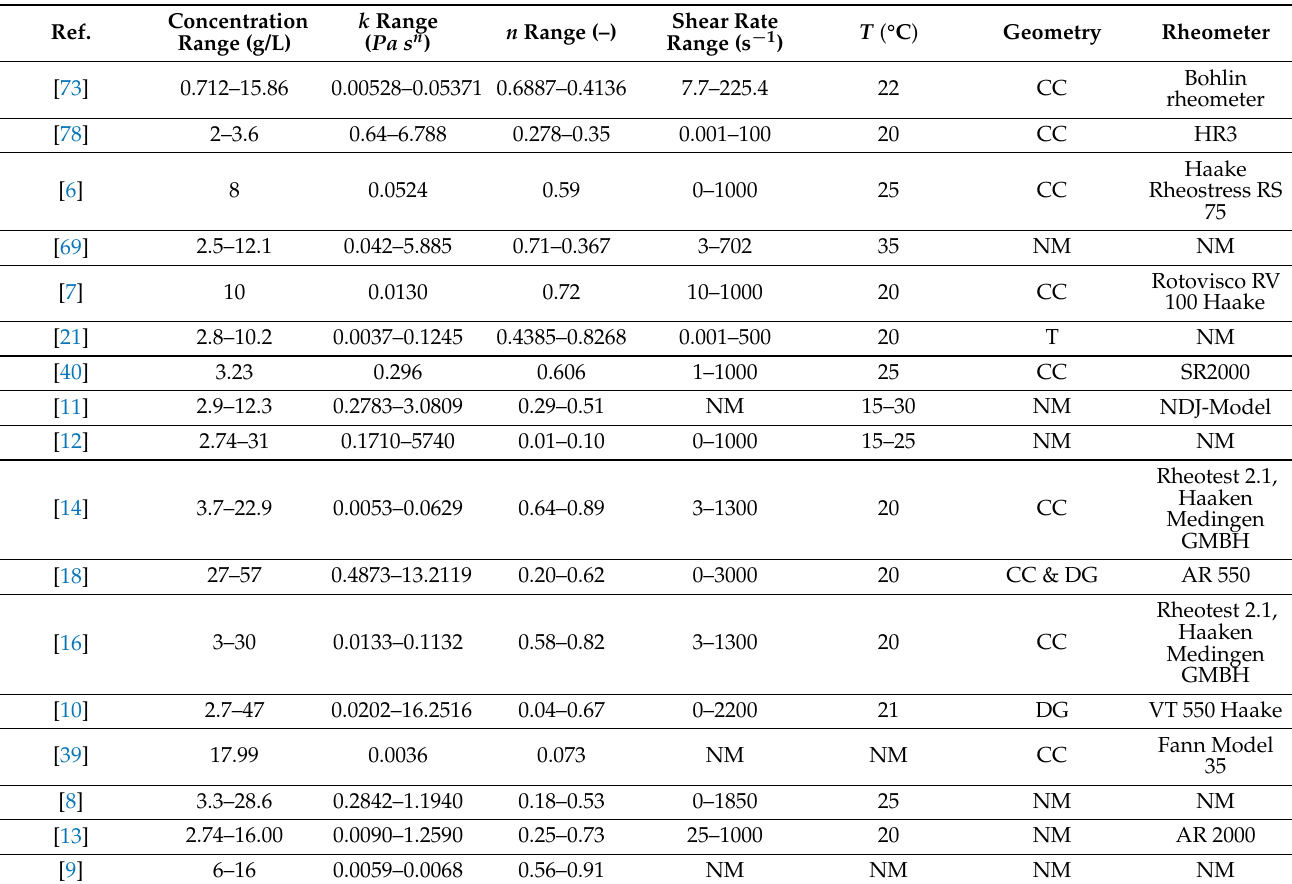
Table 14. Different rheological parameters for AS available in the literature.